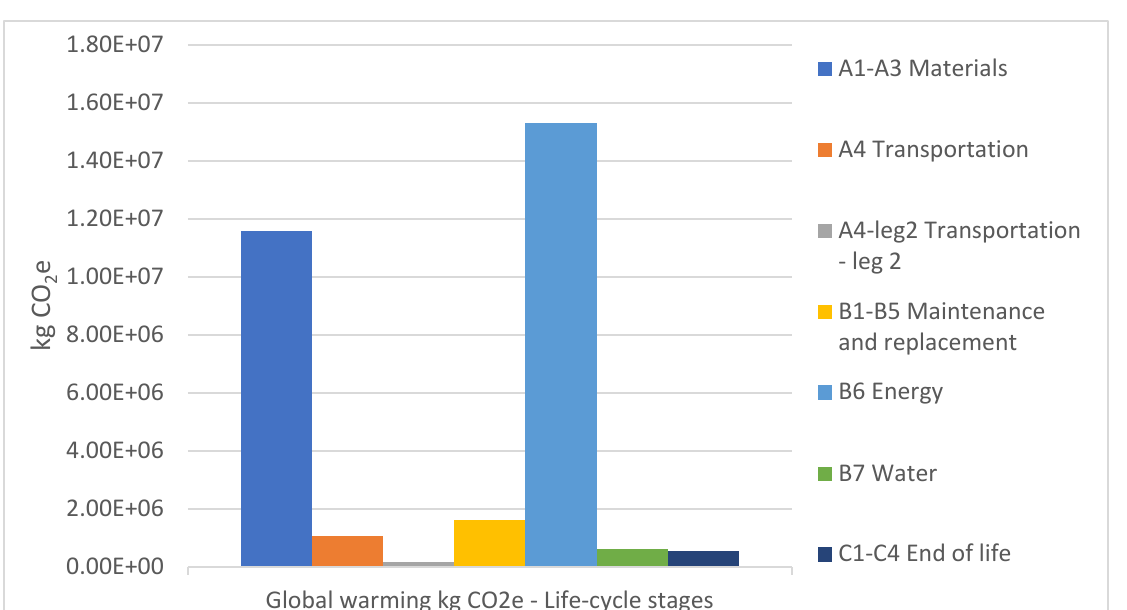
Figure 3. Life cycle impact by materials.